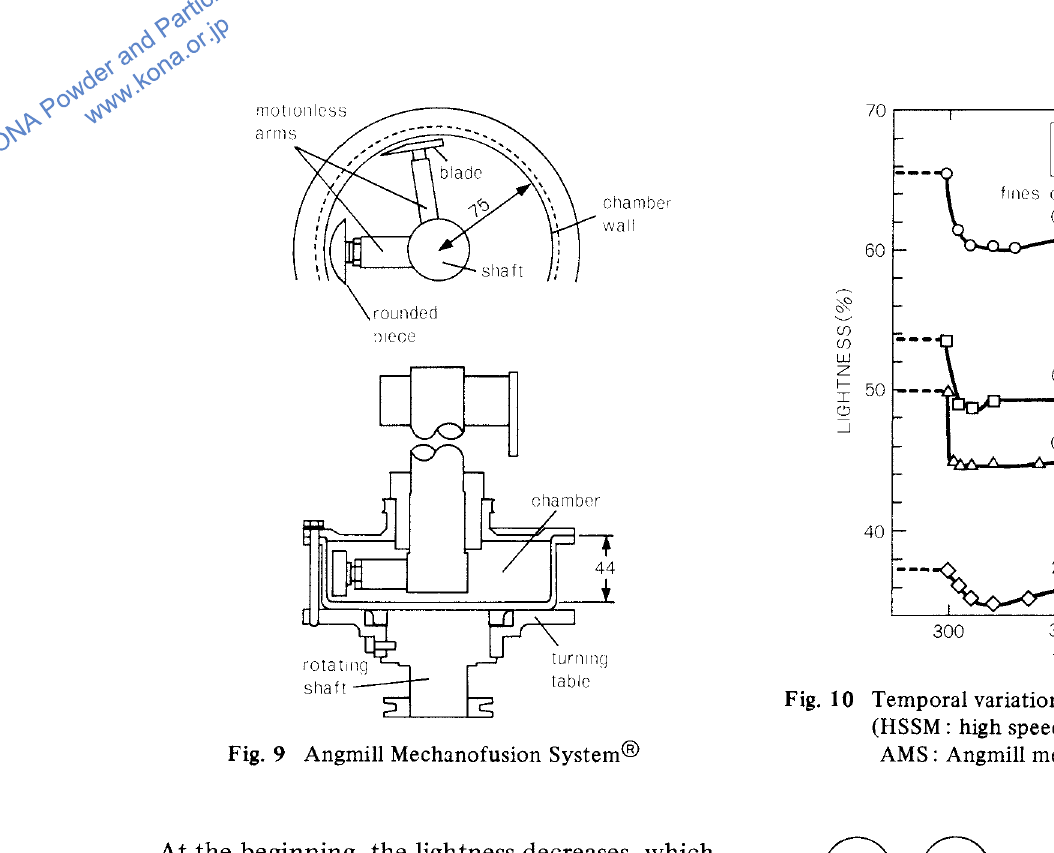
Fig. 9 Angmill Mechanofusion System®